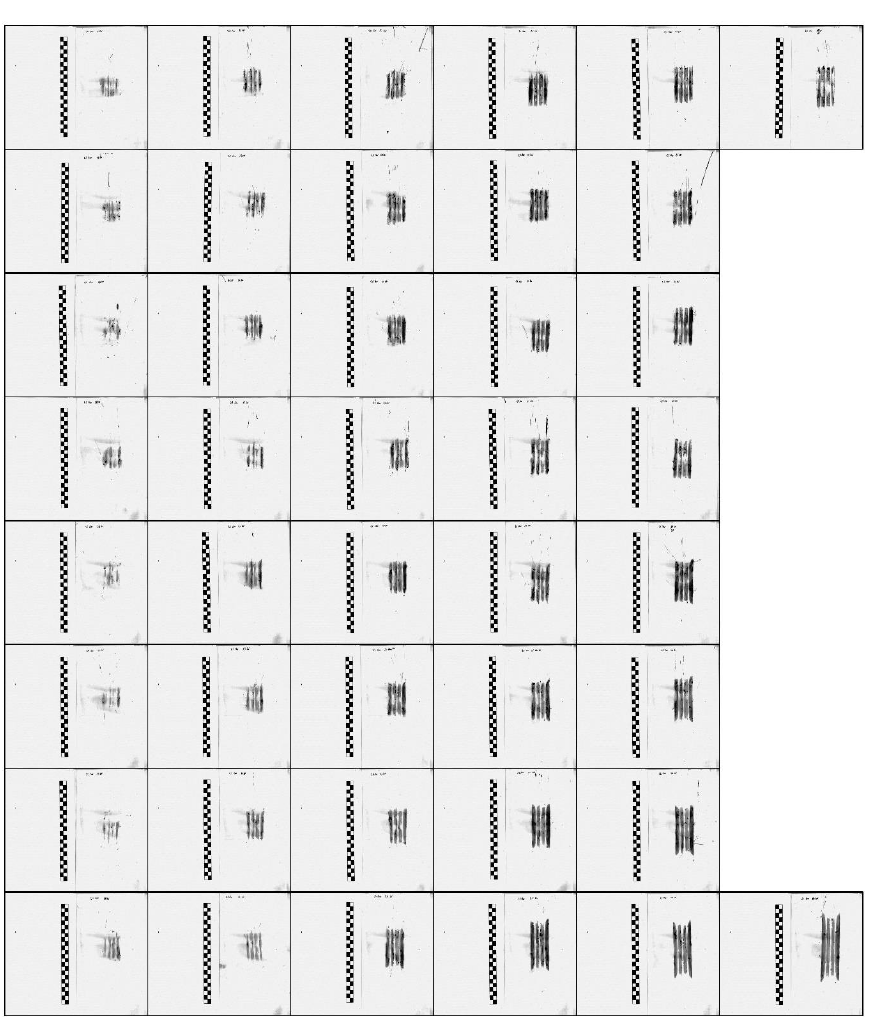
Figure 11. Negatives of wheel-to-surface contact areas for the ASFT tester wheel (T520 retreaded tire).